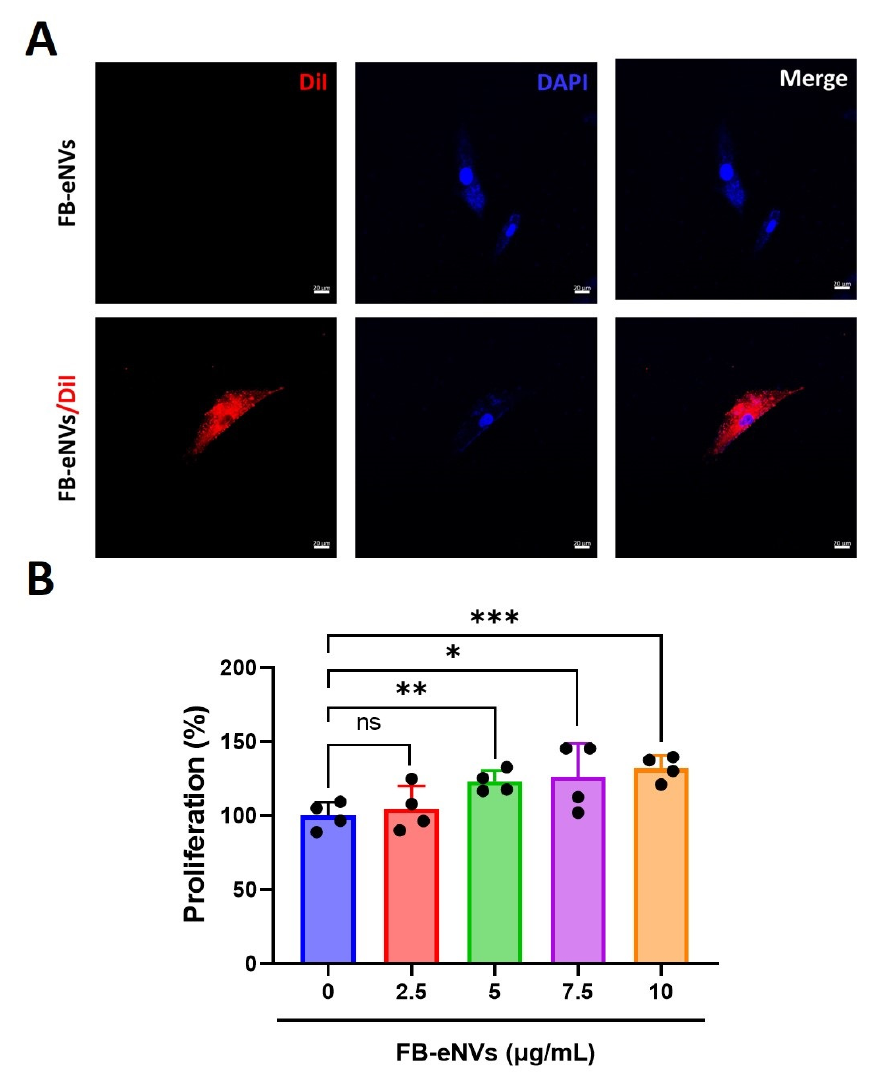
Figure 3. Cellular uptake of FB-eNVs into DP cells and proliferation of DP cells by FB-eNVs. ( A ) In vitro uptake of fluorescent stain (DiI)-labeled FB-eNVs to DP cells at 3 h. No FB-eNVs were detected in the control samples. The cell nucleus was stained with DAPI. Scale bar, 20 µm. ( B ) Percentage of proliferation of DP cells ( n = 4) at 24 h after treatment with FB-eNVs (0 to 10 µg/mL). The values are mean ± sd of a minimum of three replicates of an experiment. Student’s t -test was used. * p < 0.05; ** p < 0.01; and *** p < 0.001. ns: not significant.